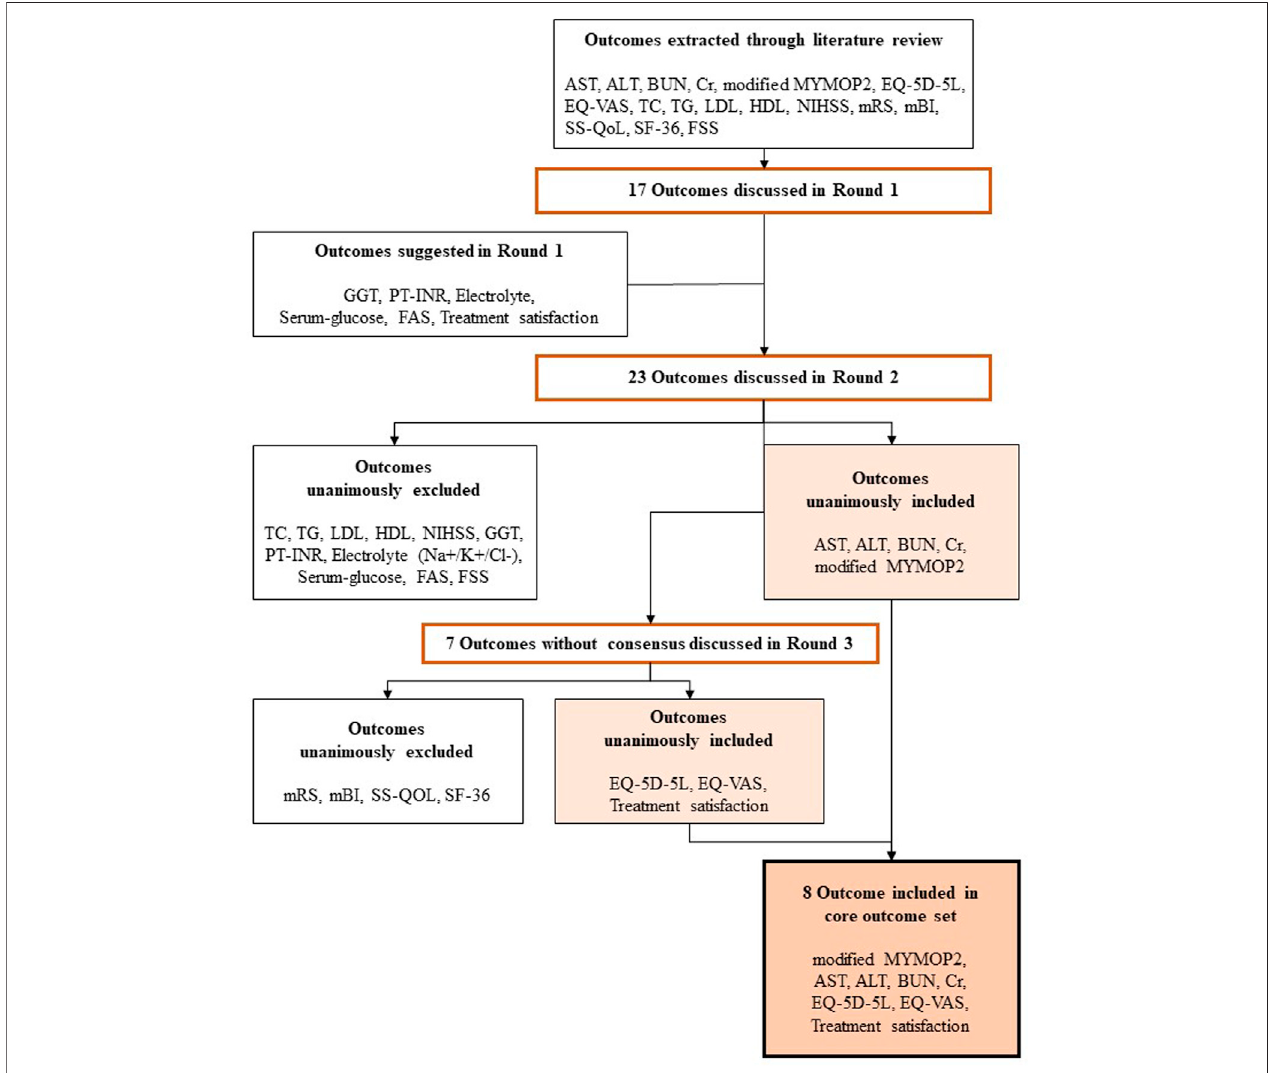
FIGURE 1 | Overview of the development of the Korean Medicine Core Outcome Set for Stroke Sequelae for (COS-SS-KM). The expert panels reached a consensus regarding the core outcome set through three rounds. In Round 2 and Round 3, the inclusion criteria for each outcome were unanimous. AST, Aspartate Transminase;ALT;AlanineTransaminase;BUN,BloodUreaNitrogen;Cr,Creatinine;MYMOP2,MeasureYourselfMedicalOutcomePro fi le2;TC,TotalCholesterol;TG, Triglyceride; LDL, Low Density Lipoprotein; HDL, High Density Lipoprotein; NIHSS, National Institute of Health Stroke Scale; mRS, modi fi ed Rankin Scale; mBI, modi fi ed Barthel Index; SS-QoL, Stroke Speci fi c Quality of Life; EQ-5D-5L, fi ve-level EuroQol 5-D; EQ-VAS, EuroQol Visual Analogue Scale; SF-36, 36-item Short Form health-survey questionnaire; FSS, Fatigue Severity Scale; GGT, Gamma-glutamyl transferase; PT-INR, Prothrombin Time International Normalized Ratio; FAS, Fatigue Assessment